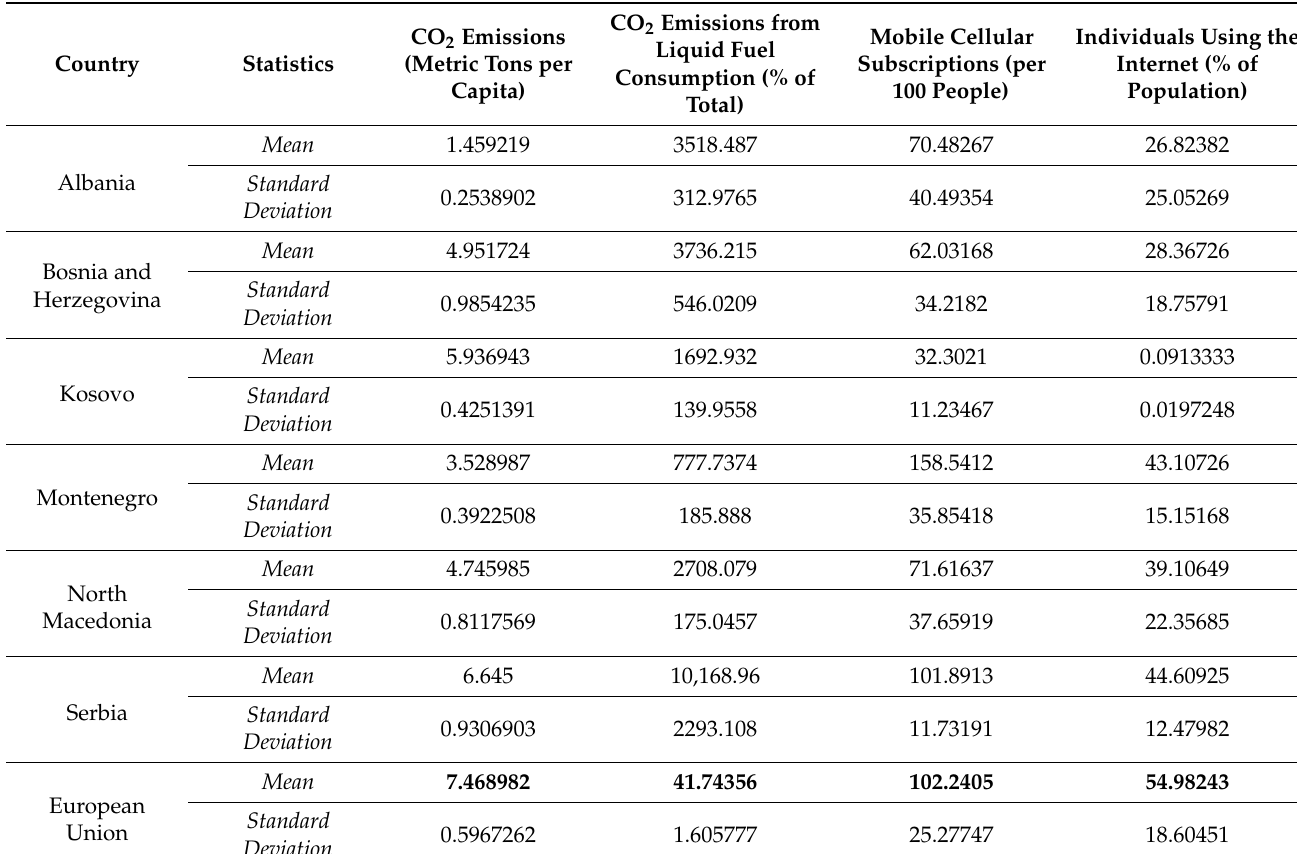
Table A1. Comparison of Western Countries with EU averages.